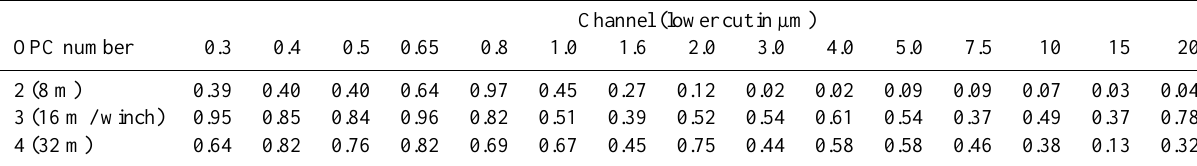
Table 1. Correction factors for each OPC when calibrated against OPC 1 (situated on the mast on the forest floor). The text in brackets next to the OPC number describes its position in the